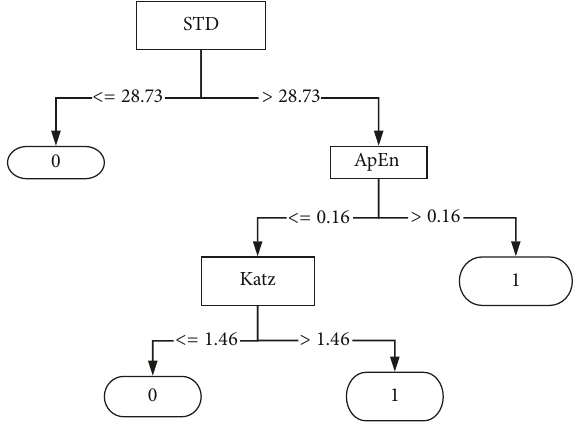
Figure 5: Performance measures of the proposed approach with varied levels of decomposition.